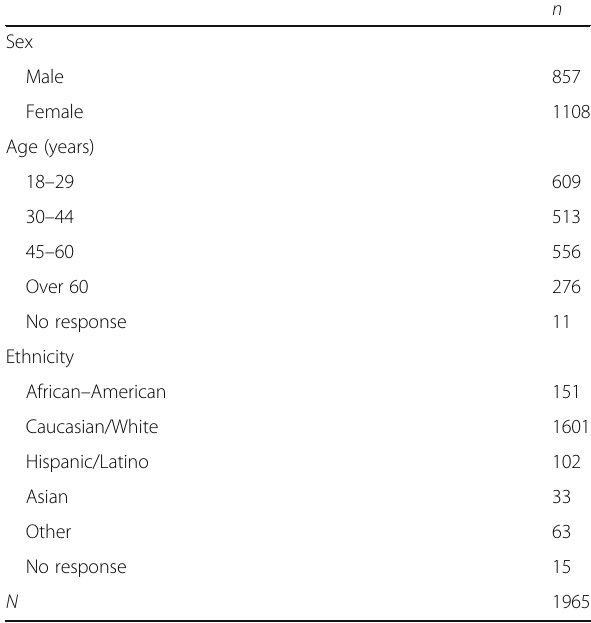
Table 3 Demographics for Experiment